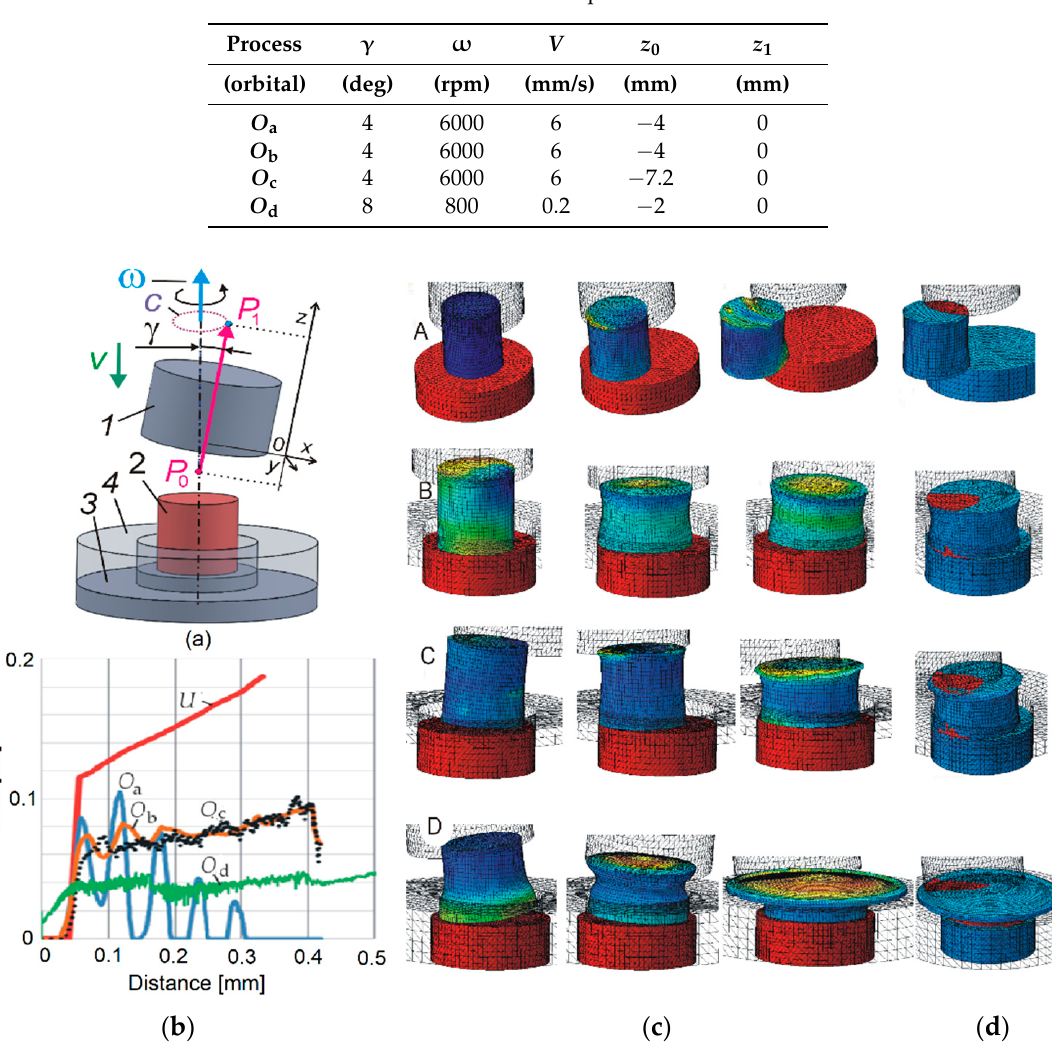
Figure 7. FEM-3d modeling of orbital forming: ( a ) Process parameters; ( b ) Forces, where U is simple upsetting and O a,b,c,d is orbital, as seen in rows A–D in ( c ); ( c ) Equivalent strain distribution; and ( d ) Contact area.